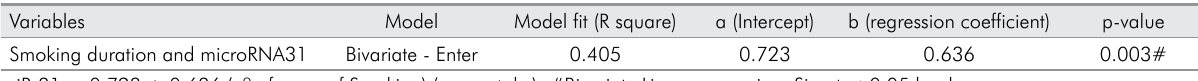
Table 3. Linear regression equation for prediction of miRNA-31 expression based on the years of tobacco smoking. Variables